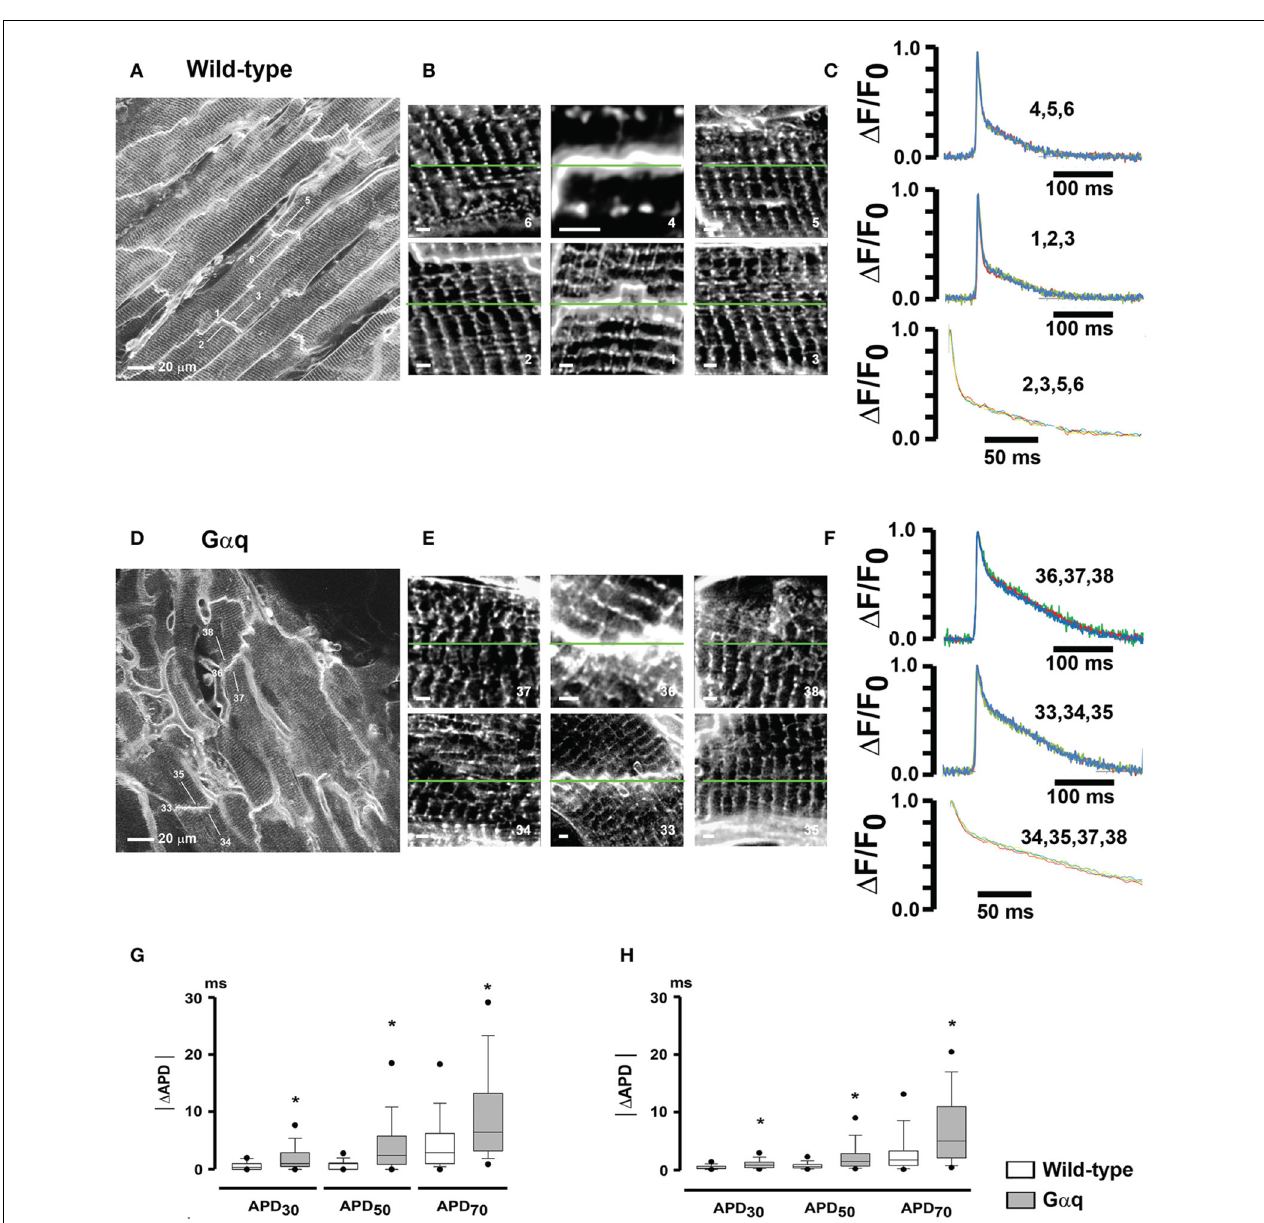
FIGURE 7 | Increased micro-heterogeneity in cardiomyocyte repolarization in hearts with pathological hypertrophy. (A,D) full-frame mode confocal images obtained from a wild-type heart (A) and a transgenic heart with cardiomyocyte-restricted overexpression of G α q (D) loaded with Annine-6plus. Numbered white lines denote positions of line-scan mode acquisitions for action potential recording. (B,E) High-zoom 2D scans of areas centered in the correspondingly numbered line-scan positions in (A,D) . Each image is composed of a square-shaped region with side length equal to the length of the respective action potential scan line. White scale bars, 5 μ m. (C,F) Overlays of normalized optical action potentials recorded along the